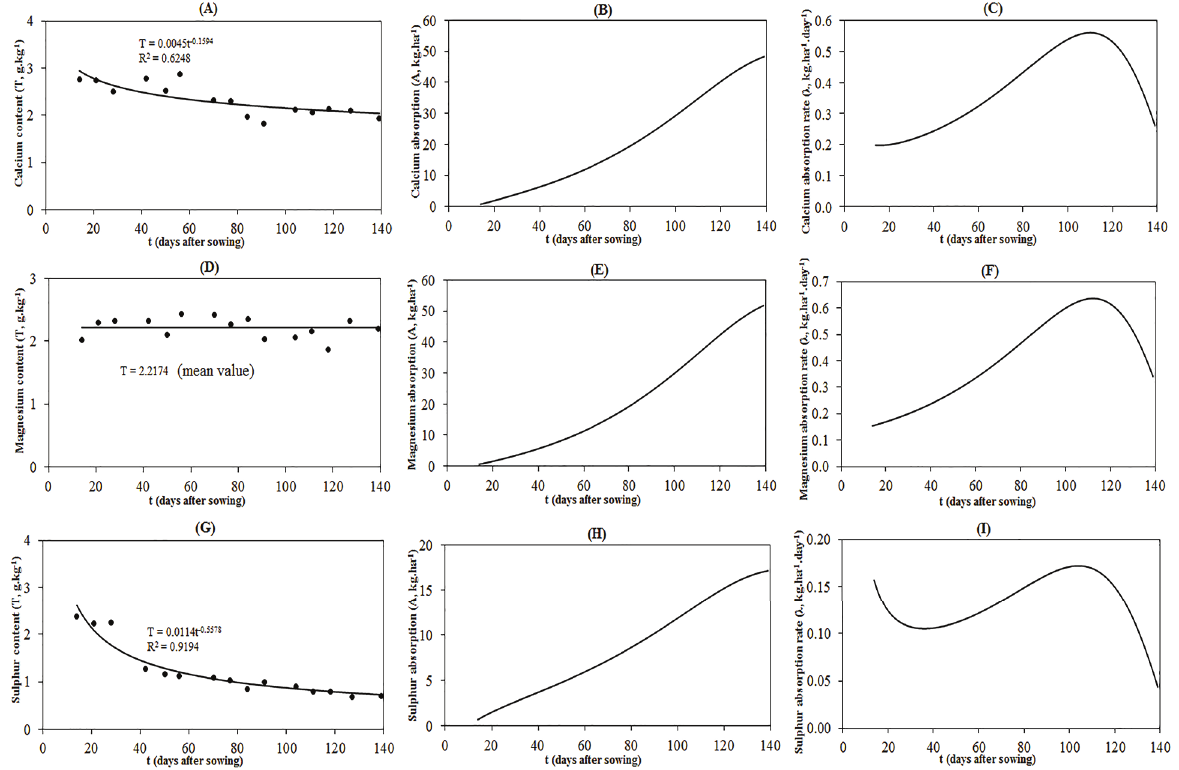
Figure 4 - Macronutrient content of the whole plant (T, g.kg -1 ), total absorption (A, kg.ha -1 ) and absorption rate (λ, kg.ha -1 .day -1 ) for calcium ( a , b and c ), magnesium ( d , e and f ), and sulfur ( g , h and i ) in the maize (hybrid DKB 390 VT PRO 2) crop (weighted average of all organs) in relation to the number days after sowing (t, days after sowing). Piracicaba (SP),